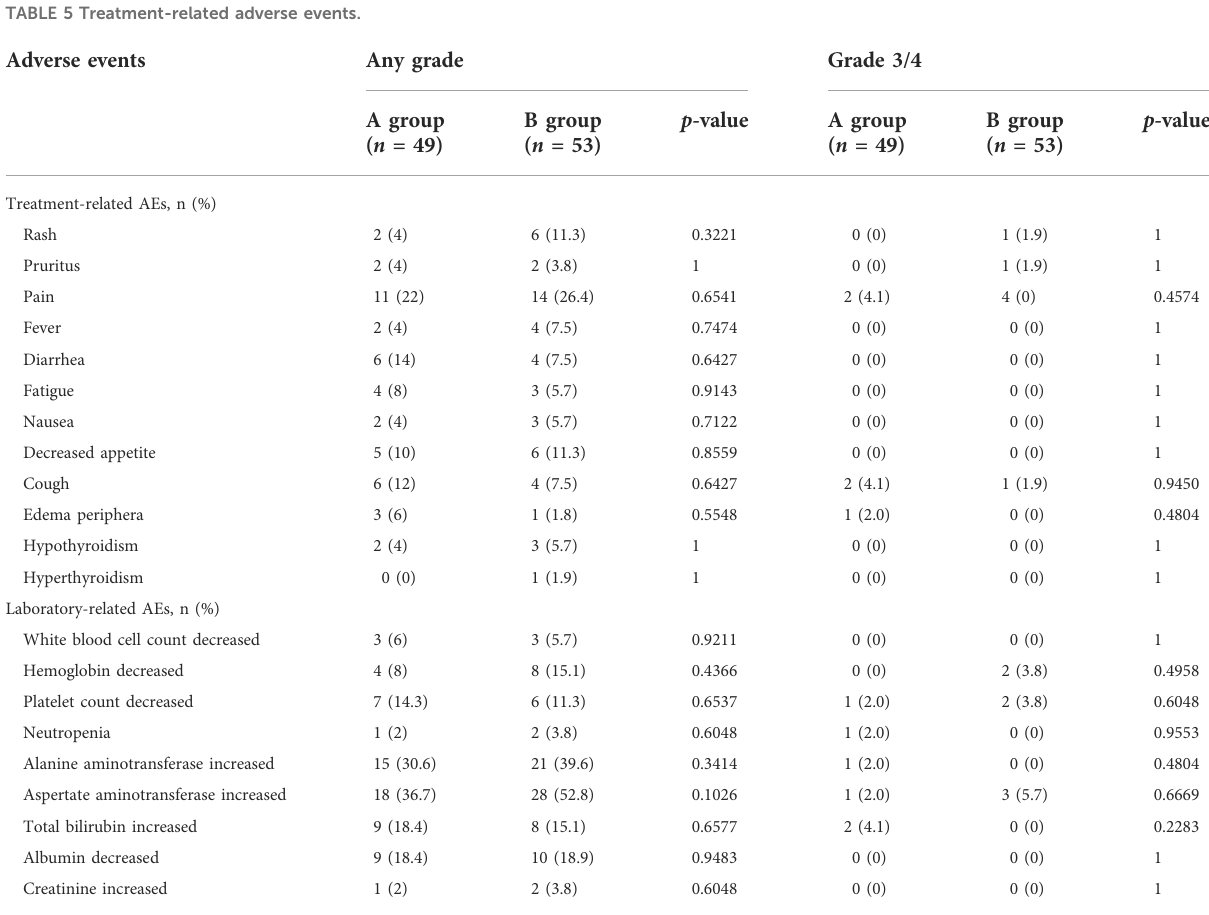
TABLE 5 Treatment-related adverse